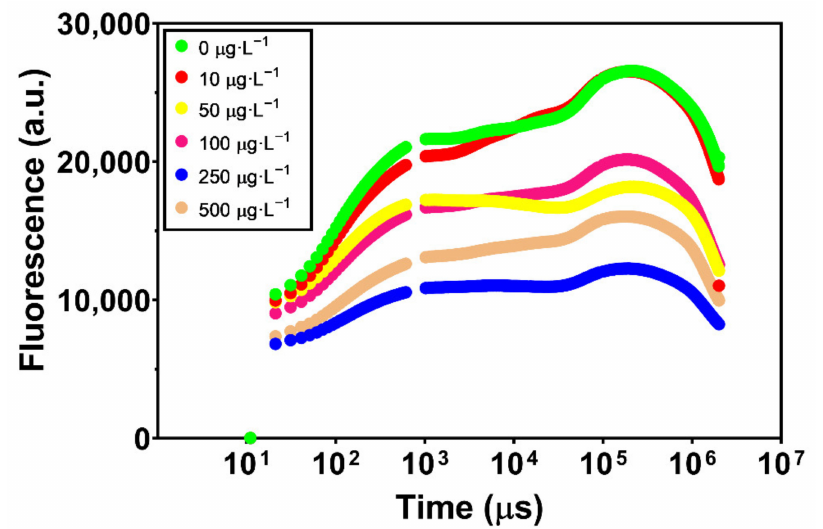
Figure 1. Chlorophyll transient kinetics (OJIP curves or Kautsky plots) in Ulva lactuca following a 48-h exposure to a glyphosate-based herbicide formulation in different concentrations (mean, n = 18). After processing the previous curves, the effects of exposure to the different herbicide concentrations in the photochemical process from light-harvesting electronic transport are evident, particularly in the higher concentrations (250 and 500 µ g · L − 1 ), presenting decreasing values in the four main energy fluxes (Figure 2). An interesting fact is how the concentration of 50 µ g · L − 1 affects U. lactuca , presenting values similar to the two highest concentrations. Although the amount of energy absorbed by the PS II antennae (ABS/CS) with 50 µ g · L − 1 is similar to control, the energy flux that was effectively trapped inside the PS II (TR/CS) is significantly lower, also observed in the case of the energy transported within the electron transport chain (ET/CS). On the other hand, the energy dissipation flux (DI/CS) is significantly different from the two highest concentrations but the reduction of the number of oxidized PS II reaction centers (RC/CS) is similar in these three concentrations (50, 250, and 500 µ g · L − 1